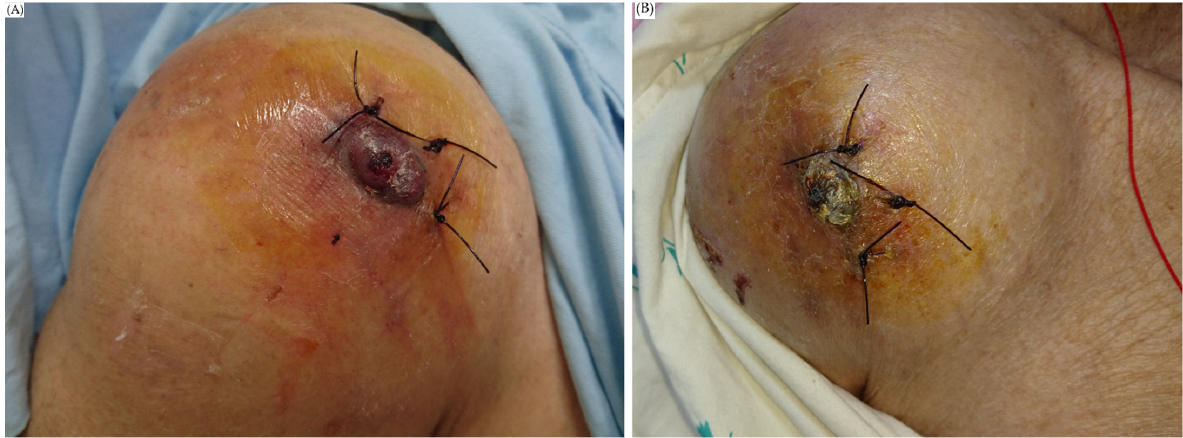
Figure 5. Right shoulder of the patient. ( A ) On the day before endovascular embolization, local heat, swelling and redness of the right shoulder were noted. The stiches were left from debridement. ( B ) One week after endovascular embolization, her shoulder was much improved in terms of swelling and pain.